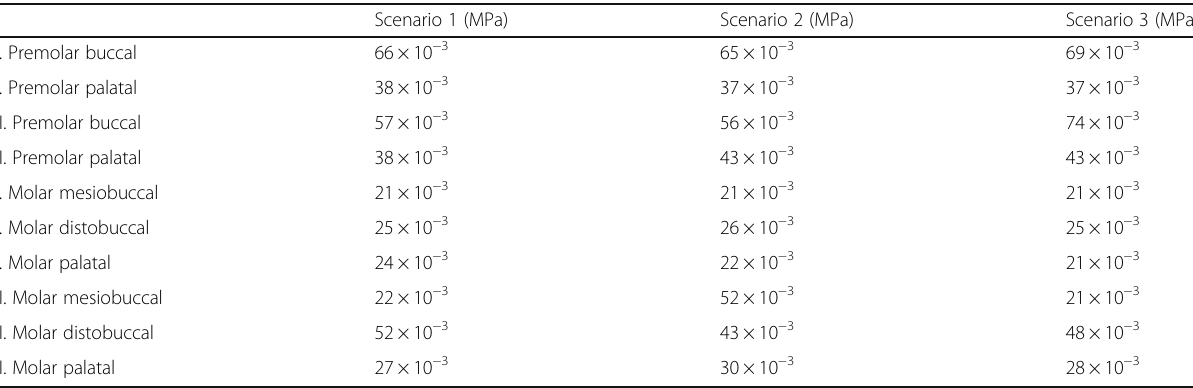
Table 4 Von Mises stress values for the cusp